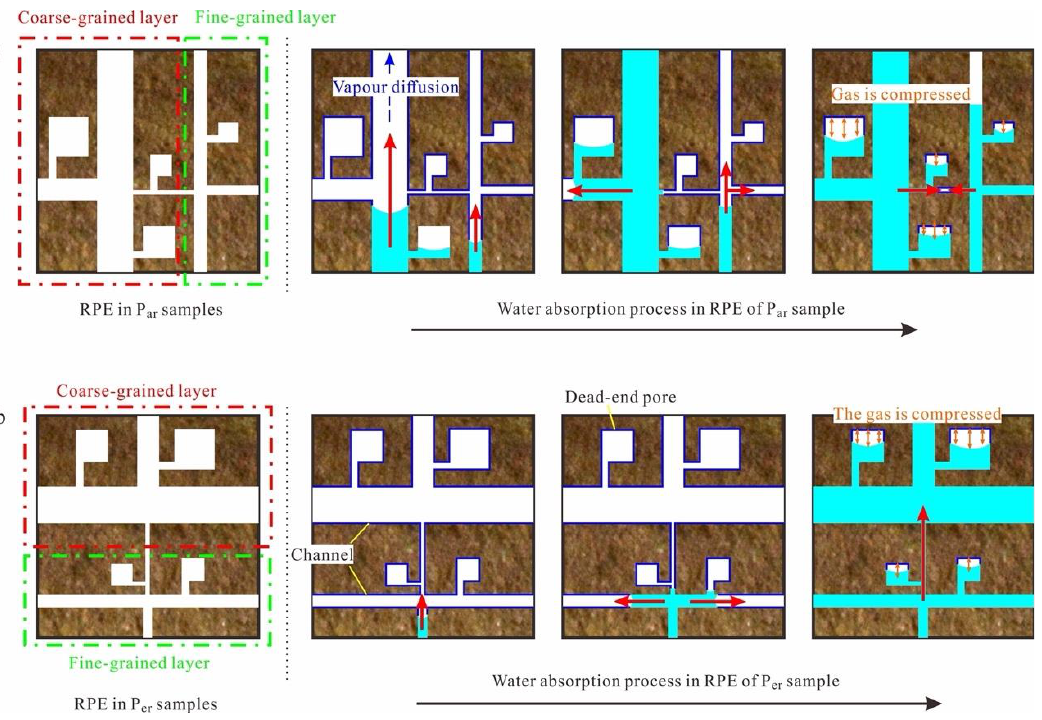
Figure 12. Capillary imbibition mechanisms in ( a ) P ar Sample; ( b ) P er